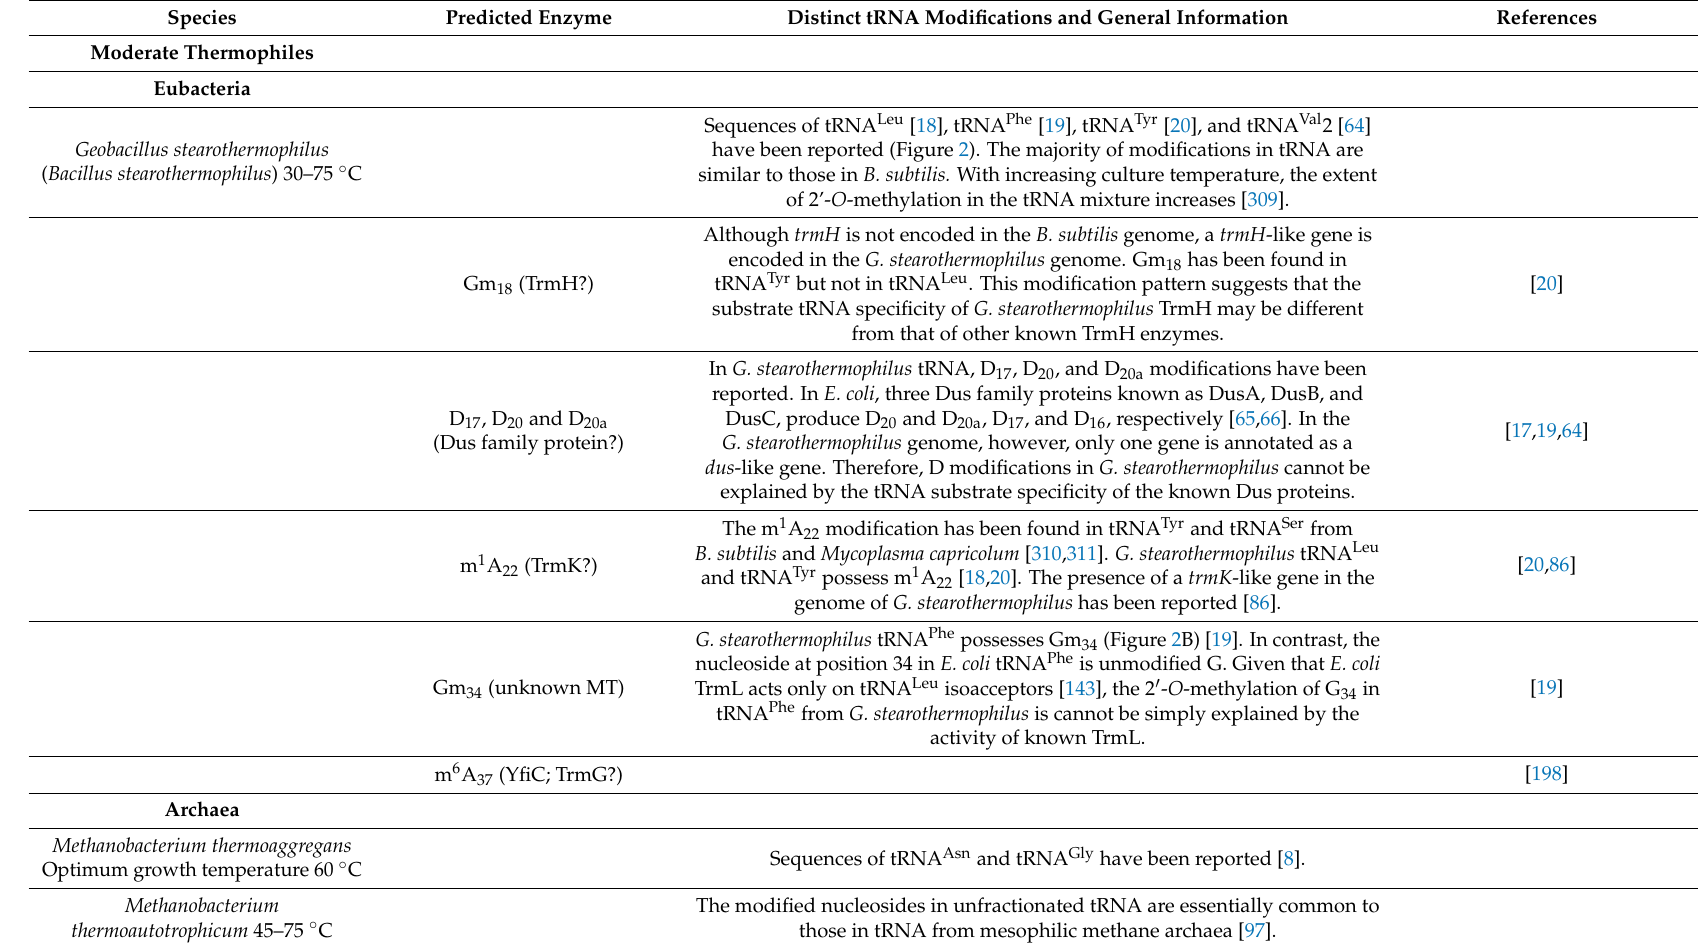
Table 2. Thermophiles: their tRNA modifications and tRNA modification